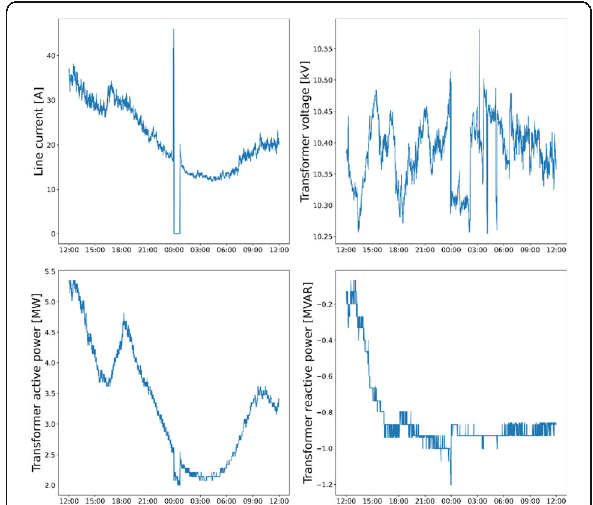
Fig. 1 (Abstract P2). Electrical signals measured at the 10 kV side of a 60/10 kV transformer station and at the head of a 10 kV distribution feeder in a Danish power distribution system. A fault in the feeder occurs at 00:00.